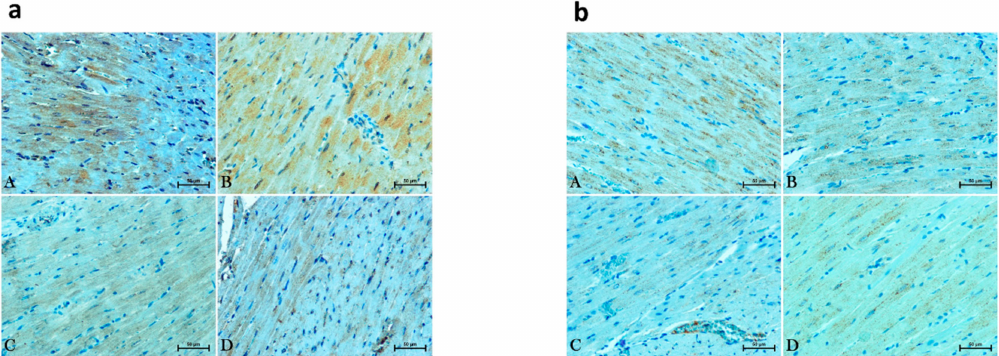
Figure 4. The e ff ect of chronic URB597 treatment on total expressions of glucose transporter 1—GLUT1 ( a ) and glucose transporter 4—GLUT4 ( b ) in the left ventricle of the control Wistar Kyoto rats (WKY) and spontaneously hypertensive rats (SHRs). Total expressions of the above proteins were presented as a percentage di ff erence compared to the control group, which was set as 100%. The data are expressed as the mean ± SD, n = 6 in each group.